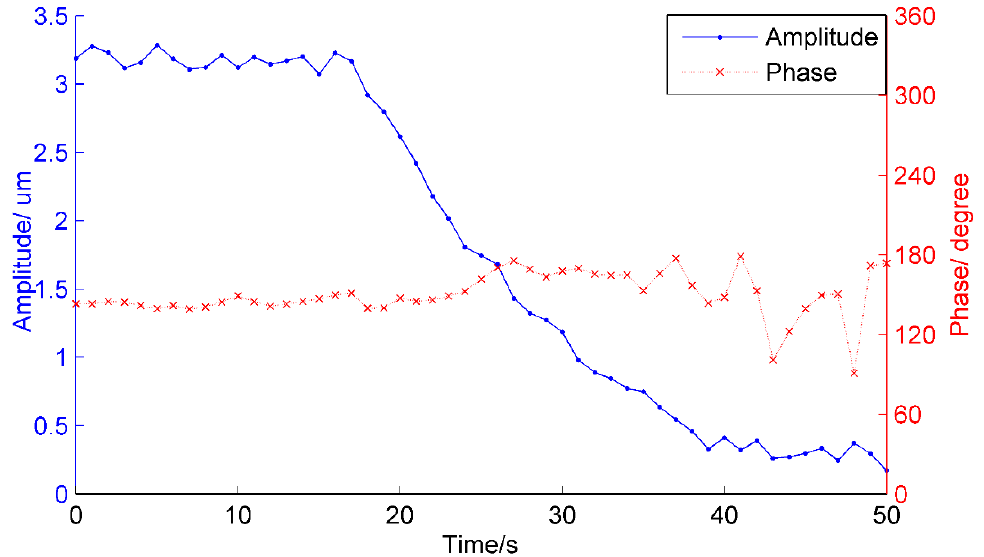
Figure 20. Active balancing experiment results of the actuator.